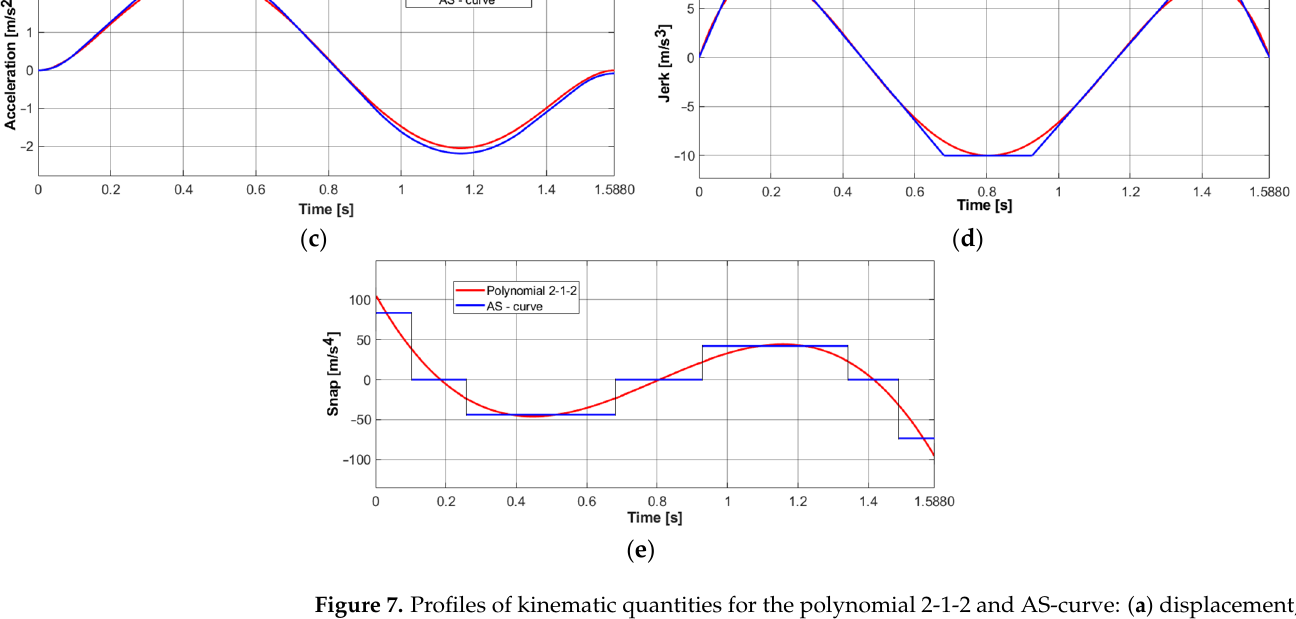
Table 4. Literature references on the occurrence of extreme kinematic parameters for polynomial profiles with constraints.